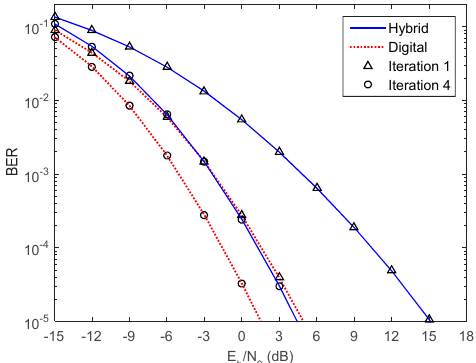
Figure 5. Performance comparison between the proposed iterative hybrid equalizer and full-digital equalizer, with N RF rx = U = 8 and N rx = 32.